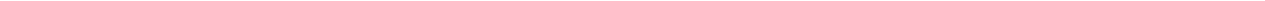
Fig. 3 Somatic copy number variations and structure variation in HSRCC. a Somatic structure variations of all patients were combined and illustrated with CIRCOS plot. Translocations between CLDN18 and ARHGAP26/6 were highlighted in red line. Recurrent mutated genes (SNV/INDEL only) were indicated in the outlier of rim and the SMGs were labeled in red (including ARHGAPs and ARHGEFs ). Cytoband was illustrated in the inner ring, followed by illustration of copy number alteration (orange represent gain and green represent loss). Structure variations were shown inside of the CIRCOS plot, red lines represent the recurrent CLDN18-ARHGAP26/6 fusions, green and black lines represent inter-chromosomal and intra-chromosomal translocations. b Illustration of breakpoint of CLDN18 and ARHGAP26/6 in DNA level (upper arrows) and RNA level (lower arrows). Fusions of CLDN18 with exon 10 of ARHGAP26 , exon 12, and ARHGAP6 were indicated with green, purple and orange upper arrows in DNA, respectively. The junctions of CLDN18 and ARHGAPs in RNA level were indicated with red, yellow, and blue lower arrows or dashed lines in the gene map demonstration and Sanger sequencing graphs,